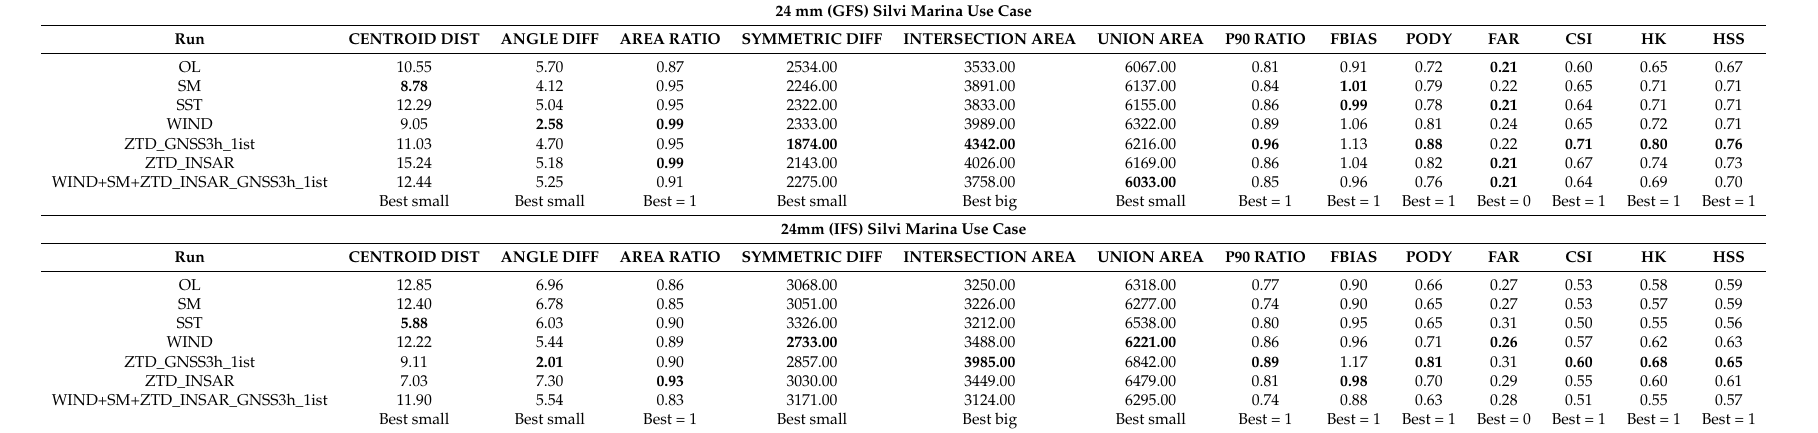
Table A7. Spatial and statistical indices calculated through MODE (24 mm rainfall depth threshold) to evaluate the sensitivity forecasts (driven by GFS and IFS respectively) with respect to the Open Loop run for the time interval 00UTC 15/11/2017–00UTC 16/11/2017. The best performance for each score is highlighted in